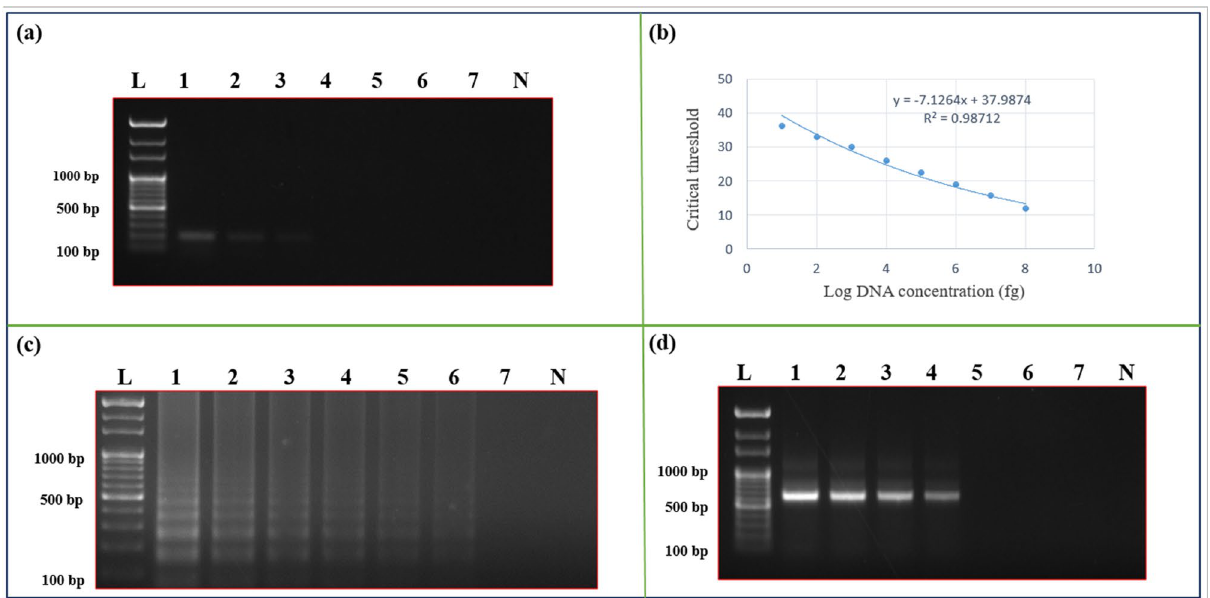
Figure 4. Comparative analysis of PCR, qPCR, LAMP assay, and HAD for their sensitivity using Sarocladium oryzae specific primers. ( a ) The sensitivity of the PCR assay, the result was visualized in a 1% agarose gel. Where lane L indicates 1 Kb ladder (Thermo Scientific), lanes 1–7 indicates 10 ng, 1 ng, 100 pg, 50 pg, 10 pg, 100 fg, 50 fg, and lane N indicates negative control. ( b ) The sensitivity of the qPCR assay. The standard curve represents log10 of DNA concentration in fg against Ct (cycle threshold) values for different DNA concentrations. ( c ) The sensitivity of the LAMP assay. The result was visualized in a 2% agarose gel. Lanes (1 to 7) indicates template DNA concentrations (10 ng, 1 ng, 100 pg, 50 pg, 10 pg, 100 fg, and 50 fg); lane N indicates negative control. ( d ) The sensitivity of the HDA assay. The result was visualized in a 1% agarose gel. Lanes (1 to 7) indicates template DNA concentrations (10 ng, 1 ng, 100 pg, 50 pg, 10 pg, 100 fg, and 50 fg), lane N indicates negative control, and lane L indicates 1 kb ladder (Thermo